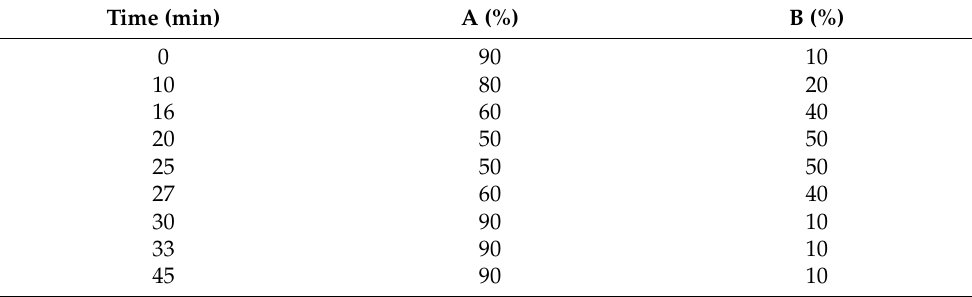
Table 3. Chromatographic